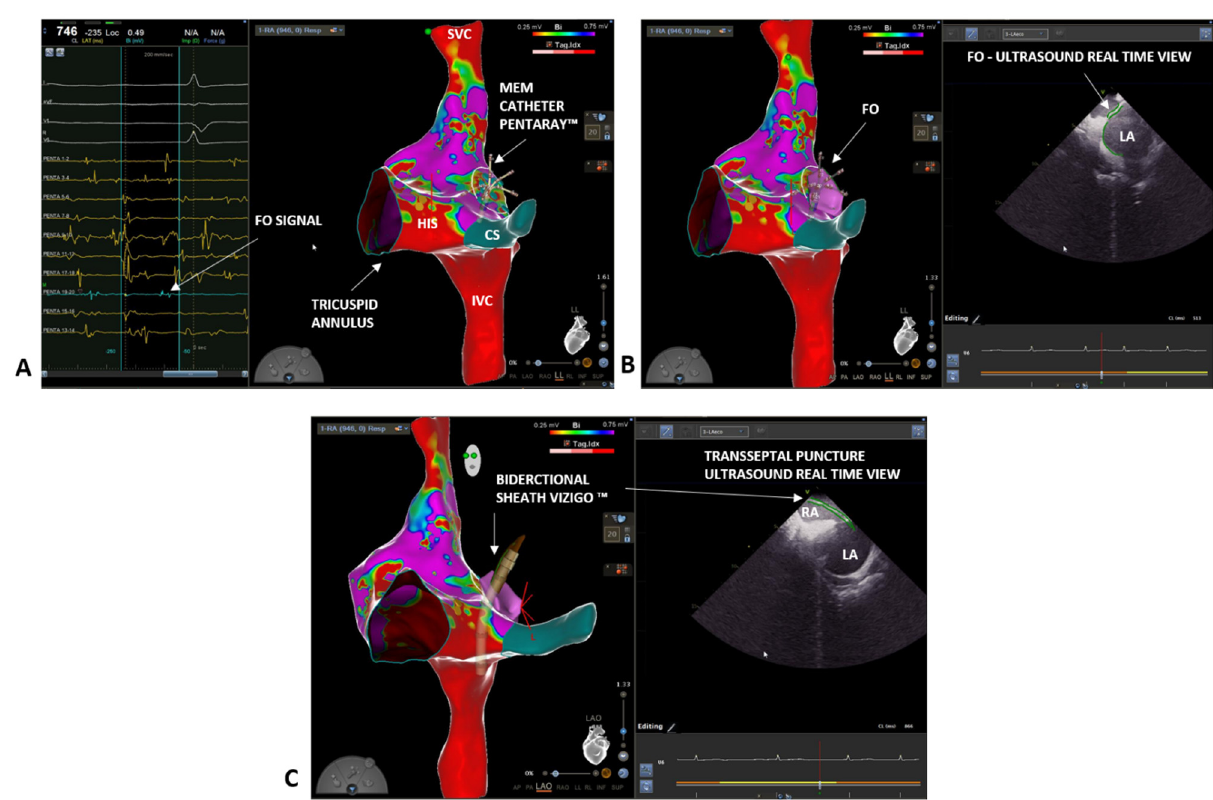
Figure 2. ( A ) Right atrium bipolar map (0.25–0.75 mV) (LL projection). Pentaray™ identification of the fragmented and low voltage signals, typical of the fossa ovalis (FO) area (blue tags). ( B ) Confirmation of FO location thanks to the ICE catheter and co-registration with the electro-anatomical map (LL projection) with CartoSound ® module. ( C ) Transseptal puncture with the VIZIGO™ steerable sheath, confirmed by ICE imaging. FO = fossa ovalis; SVC = superior vena cava; IVC = inferior vena cava; CS = coronary sinus.